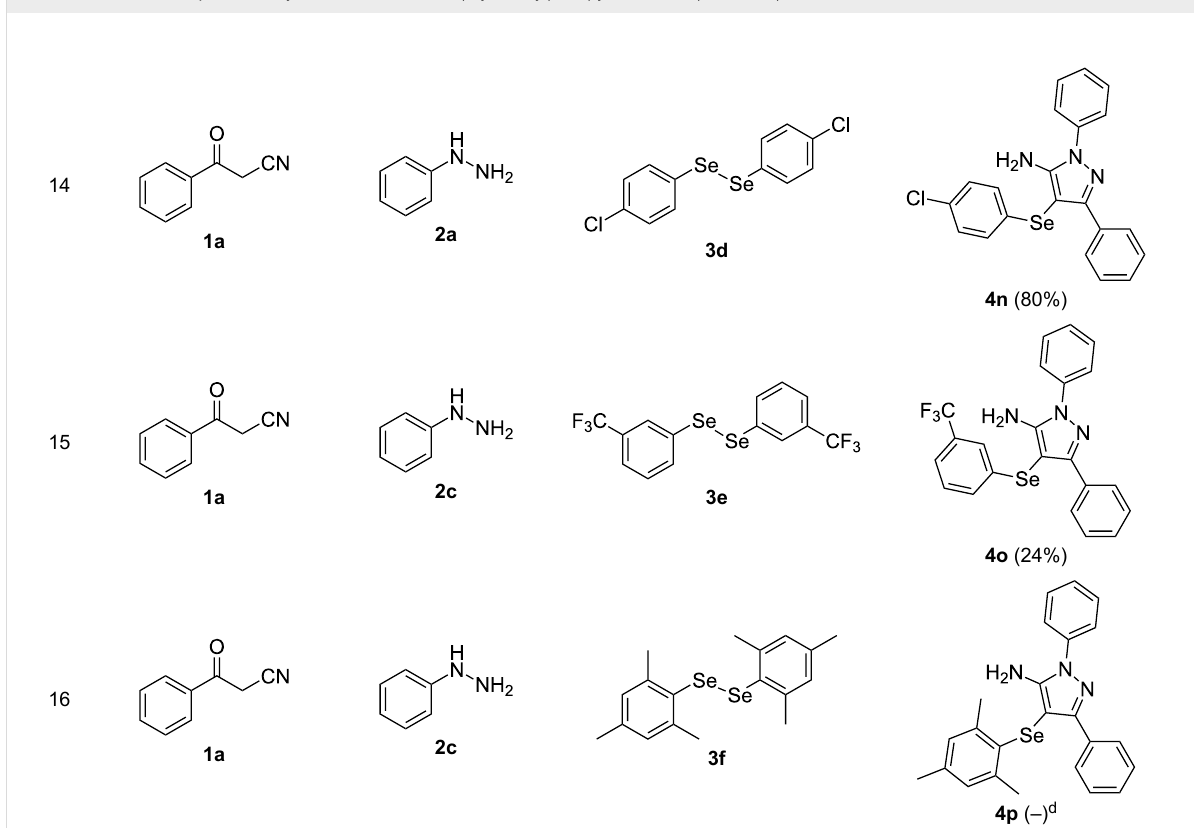
Table 2: Substrate scope for the synthesis of 5-amino-4-(arylselanyl)-1 H -pyrazoles 4 . a